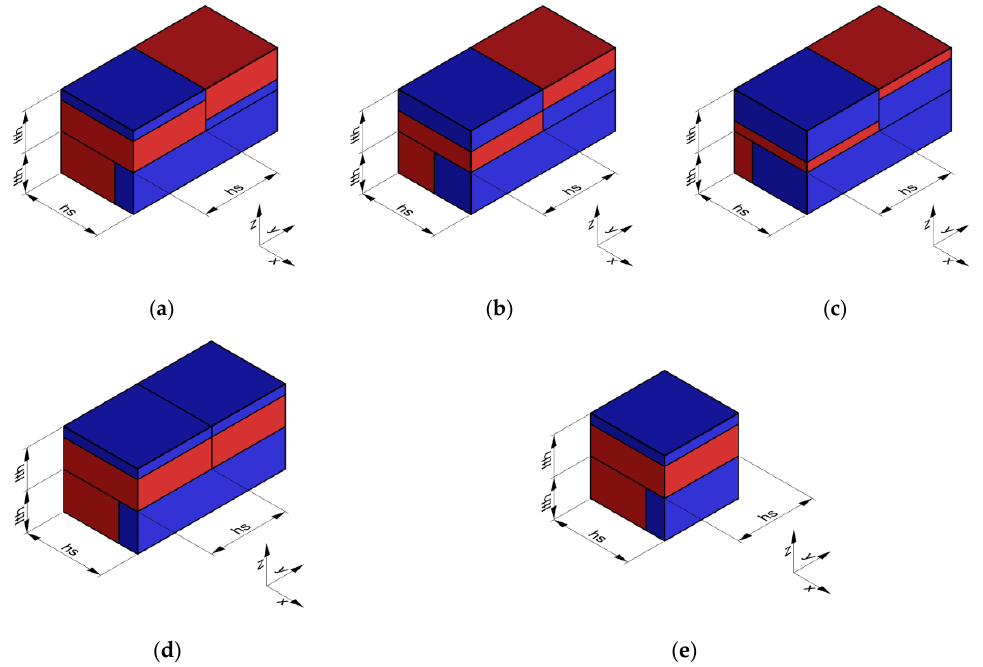
Figure 4. Volume element of deposited material: the first layer is deposited in the y-direction, whereas the second layer is deposited in the x- direction. Blue represents a generic “A material”, and red represents a generic “B material”. In ( a ), the volume element is made up of 25% of the “A mate- rial” and 75% of the “B material”, in ( b ), there is 50% of “A” and 50% of “B”, and in ( c ), there is 75% of “A” and 25% of “B”. Simplified model for elastic modulus estimation: ( d ) flipped material ex- truded along the x-positive direction; ( e ) reduced length.